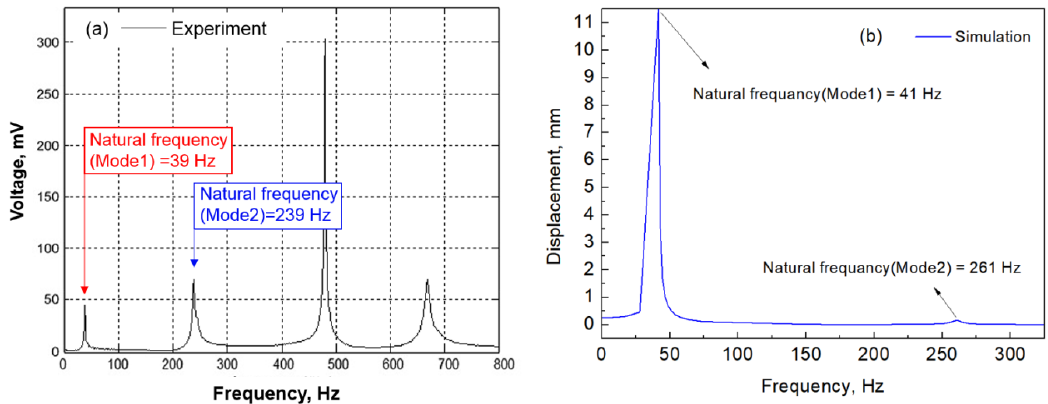
Figure 4. Frequency response curve of RT-LSPed samples: ( a ) Experiment, ( b ) Simulation.